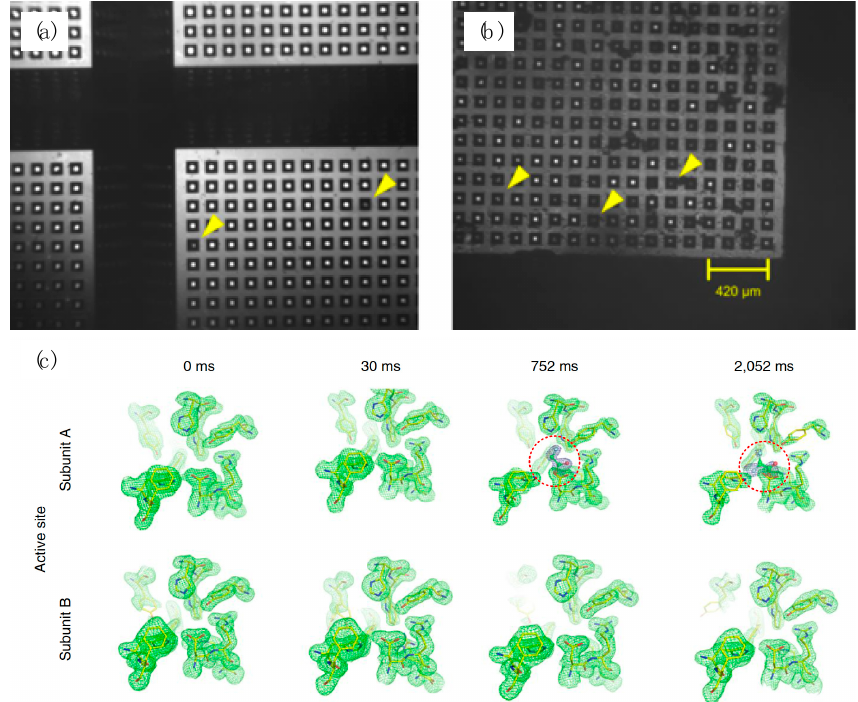
Figure 8. Hit-and-return ( HARE) method. ( a ) An empty chip is shown as a control. The yellow arrows point out underdeveloped features, which appear semi-transparent under infrared (IR) light illumination. ( b ) Loaded chip with yellow arrows representing crystals sitting in the features of the chip. Crystals sitting inside of the features can be clearly distinguished from crystals on its surface and from empty features. ( c ) Changes in fluoroacetate dehalogenase (FAcD) electron density as a function of t for the active site subunits A and B. Electron density maps are at a cutoff of 2 σ (green, protein; blue, ligand (highlighted with red circle)). Figure adapted from Reference [99] with permission from Springer Nature.